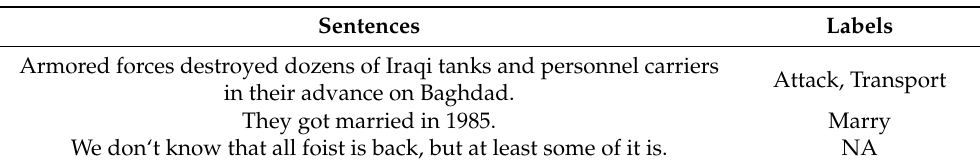
Attack, Transport